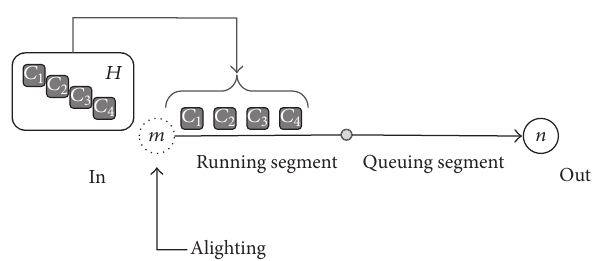
Figure 3: Scheme of operations taking place in alighting arc.